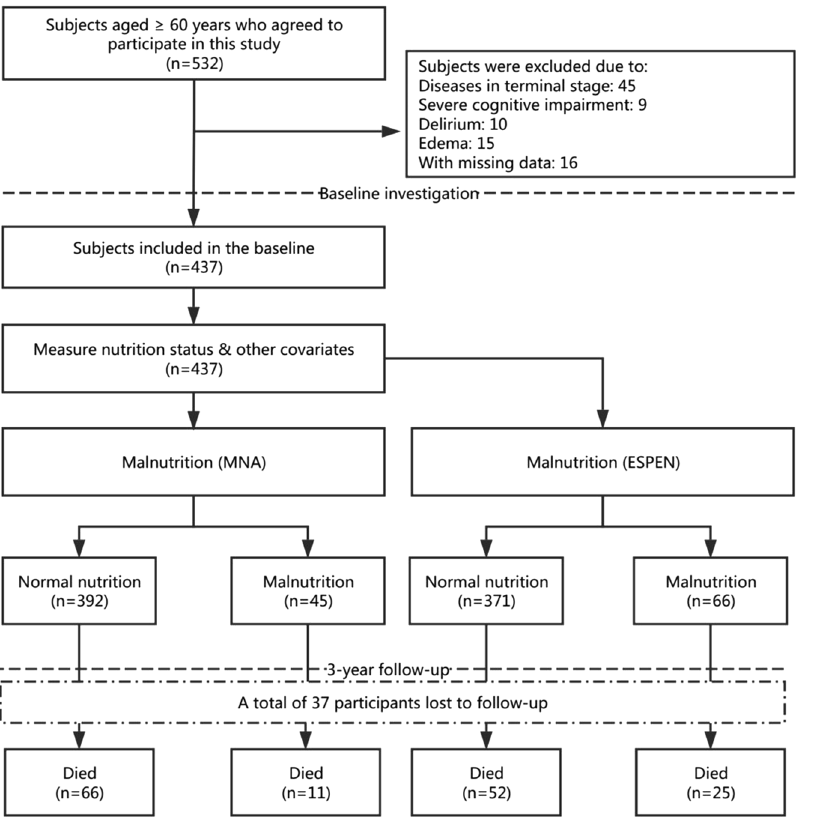
Figure 1. The flowchart of the study